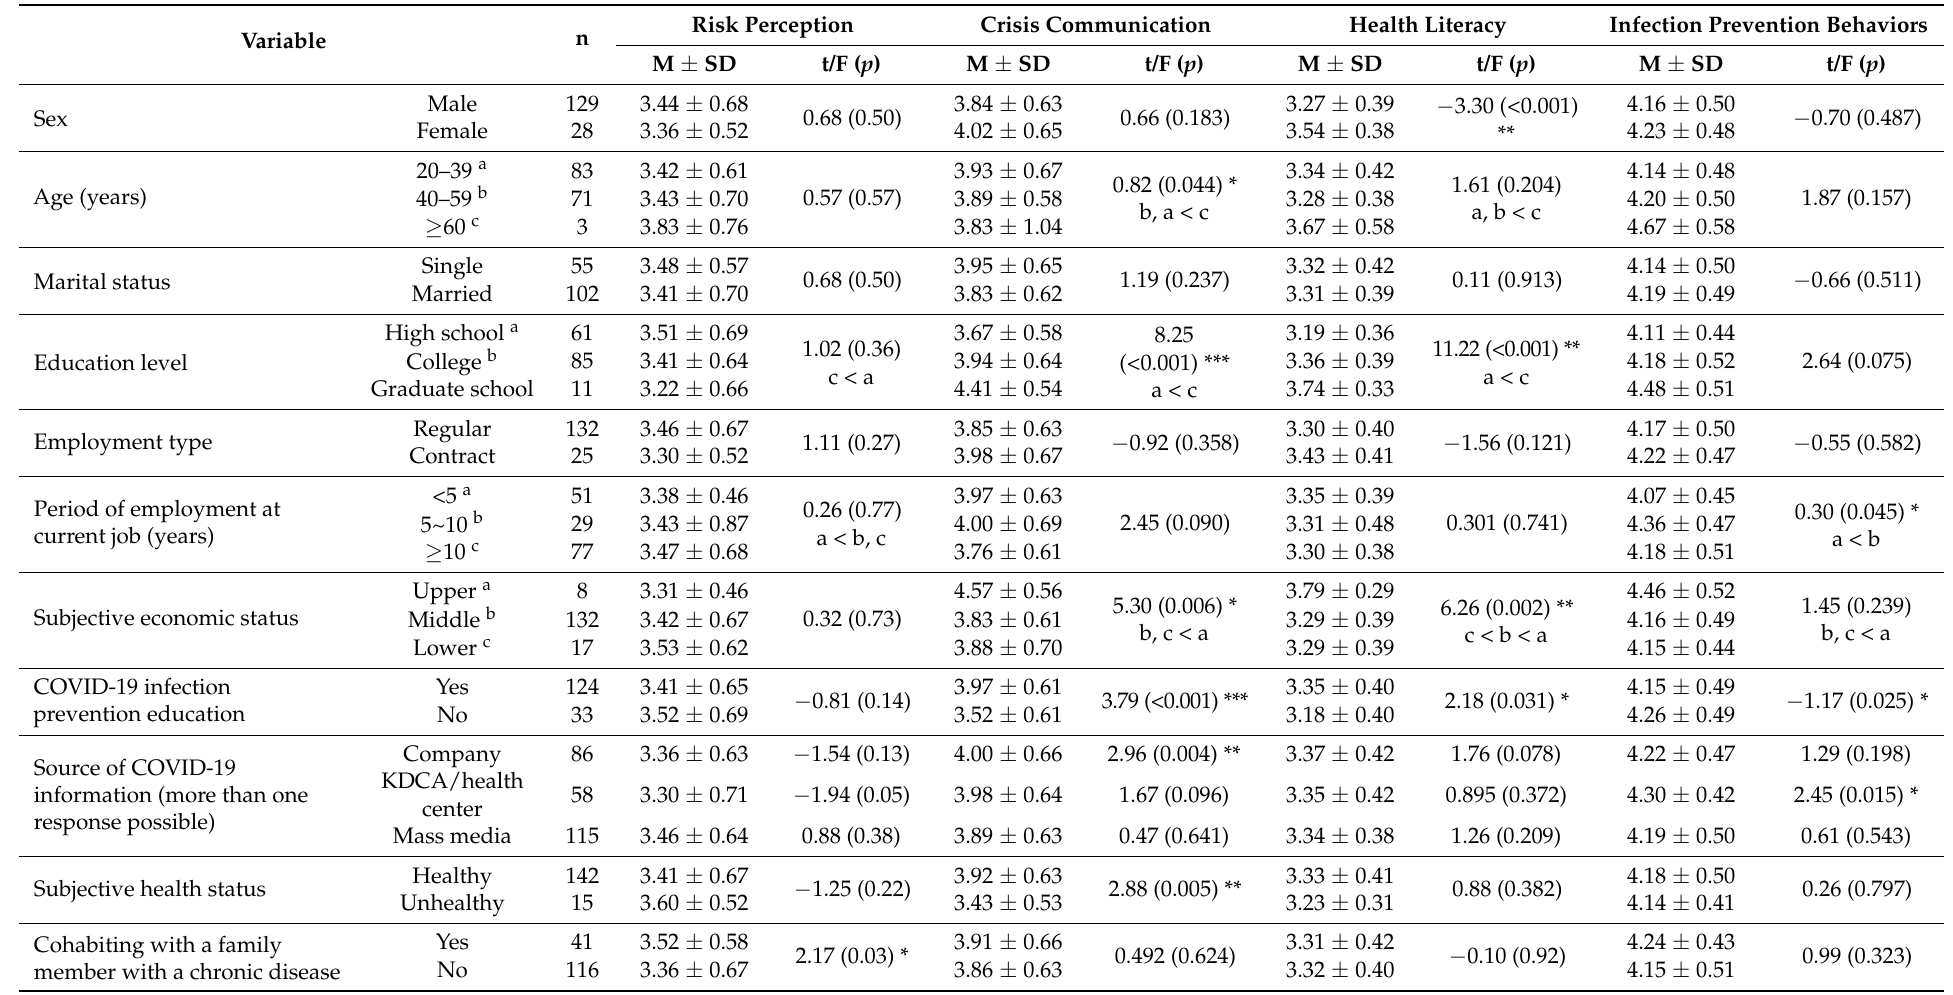
Table 4. COVID-19 risk perception, crisis communication, COVID-19 health literacy, and infection prevention behaviors according to the general characteristics (N =